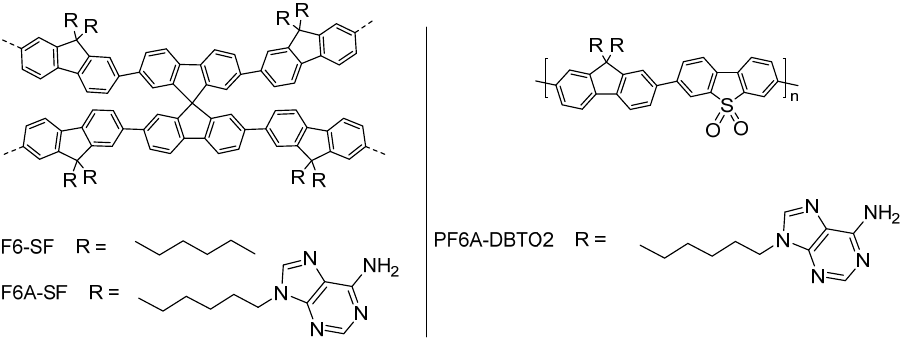
Figure 13. Structures of adenine substituted conjugated polymers for sacrificial hydrogen production from water [98,99].